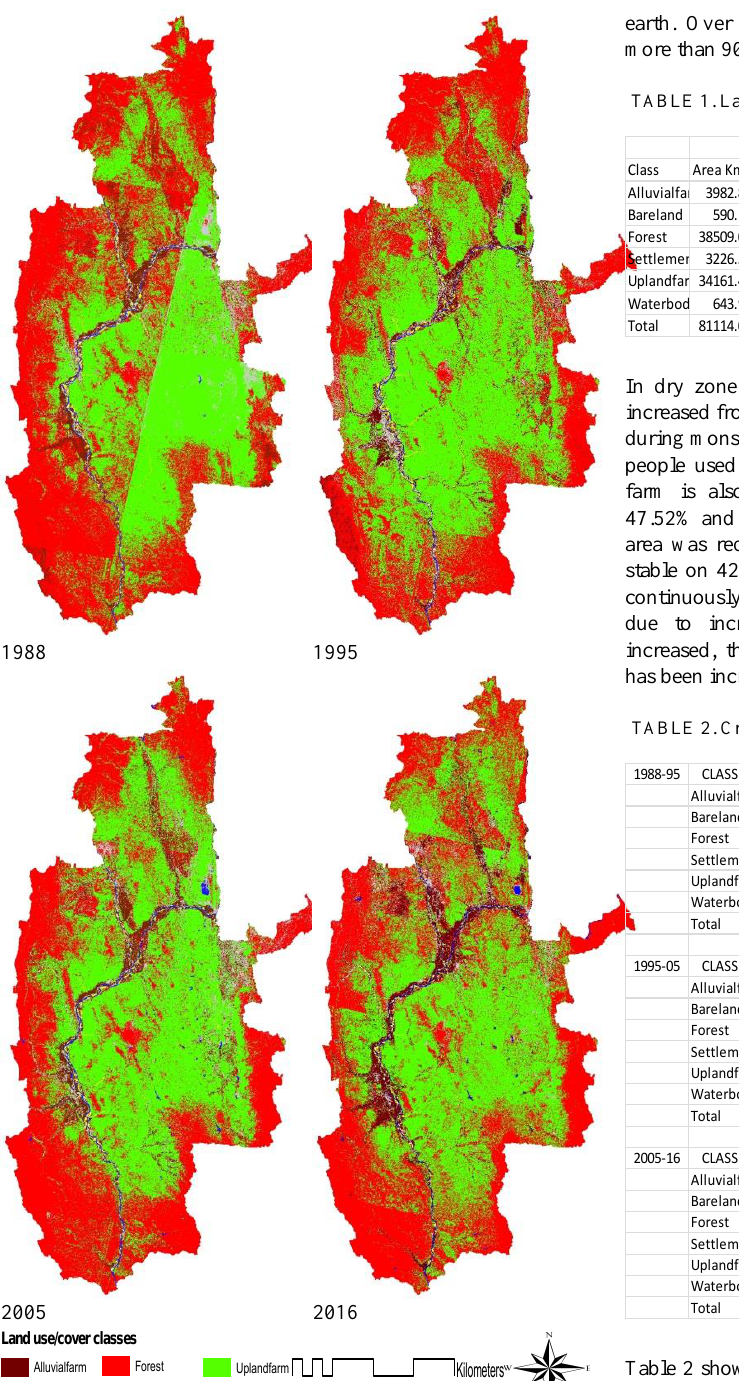
Figure 2. Land use/cover maps from 1988 to 2016 for central dry zone area of Myanmar.